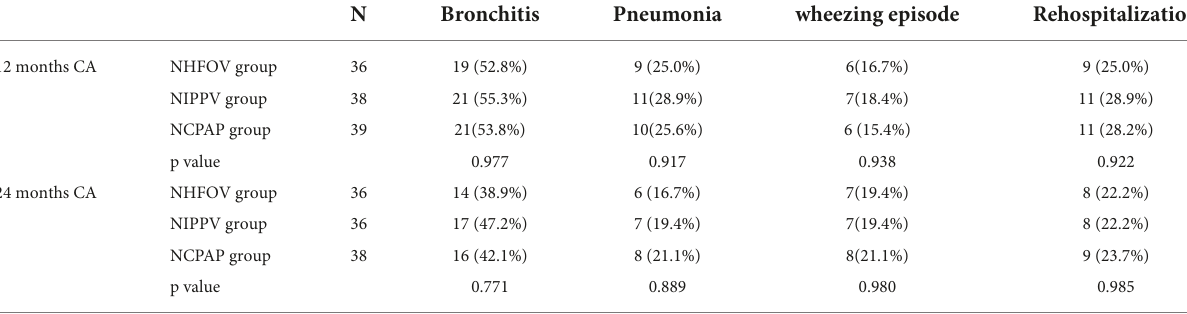
TABLE 1 Respiratory morbidities at 12- and 24-month CA (number of times). N Bronchitis